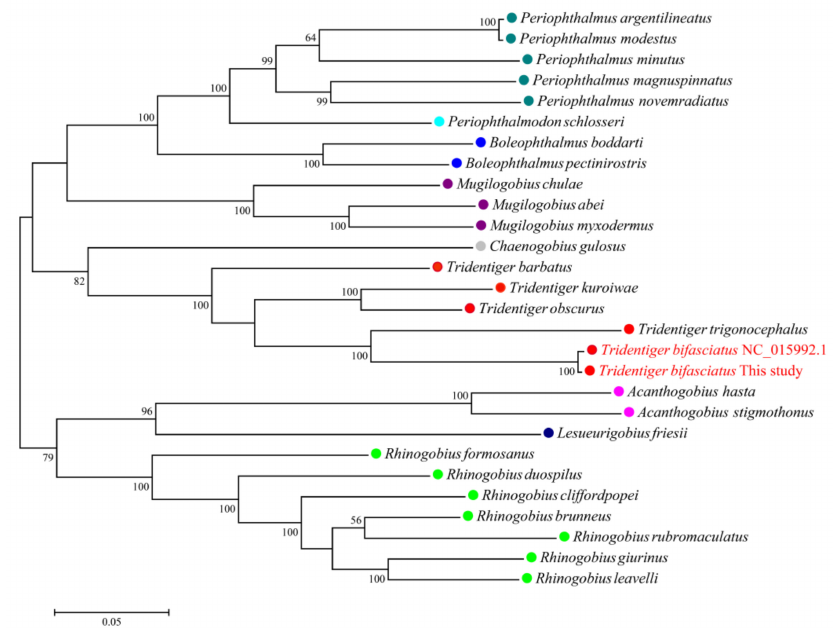
Figure 9. Maximum likelihood phylogenetic trees inferred from mitochondrial genomes of Gobiidae species based on 13 protein-coding genes. The same color represents species of the same